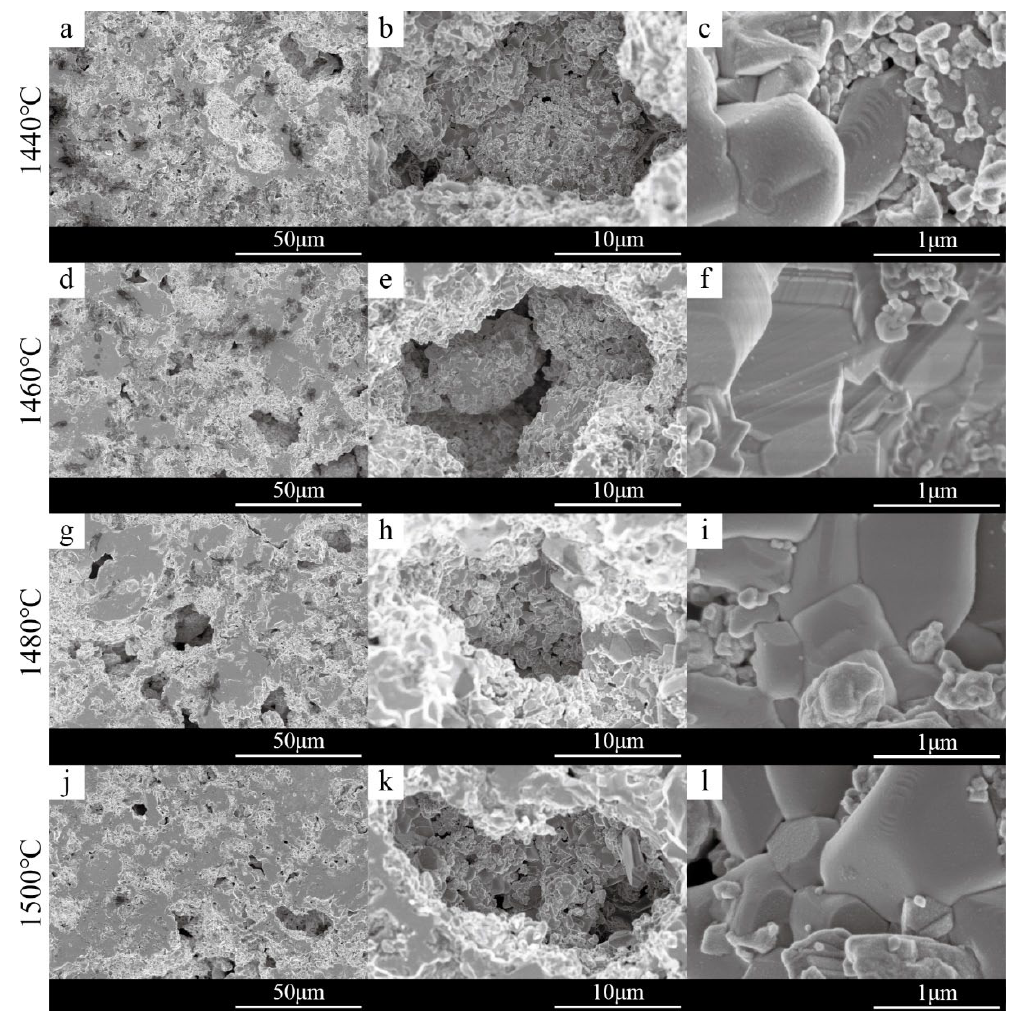
Fig. 2 Microstructure of porous ceramics sintered at 1440, 1460, 1480, 1500 ℃ : (a, d, g, j) the overall appearance of the pores, (b, e, h, k) open pores, and (c, f, i, l) Ti 3 SiC 2